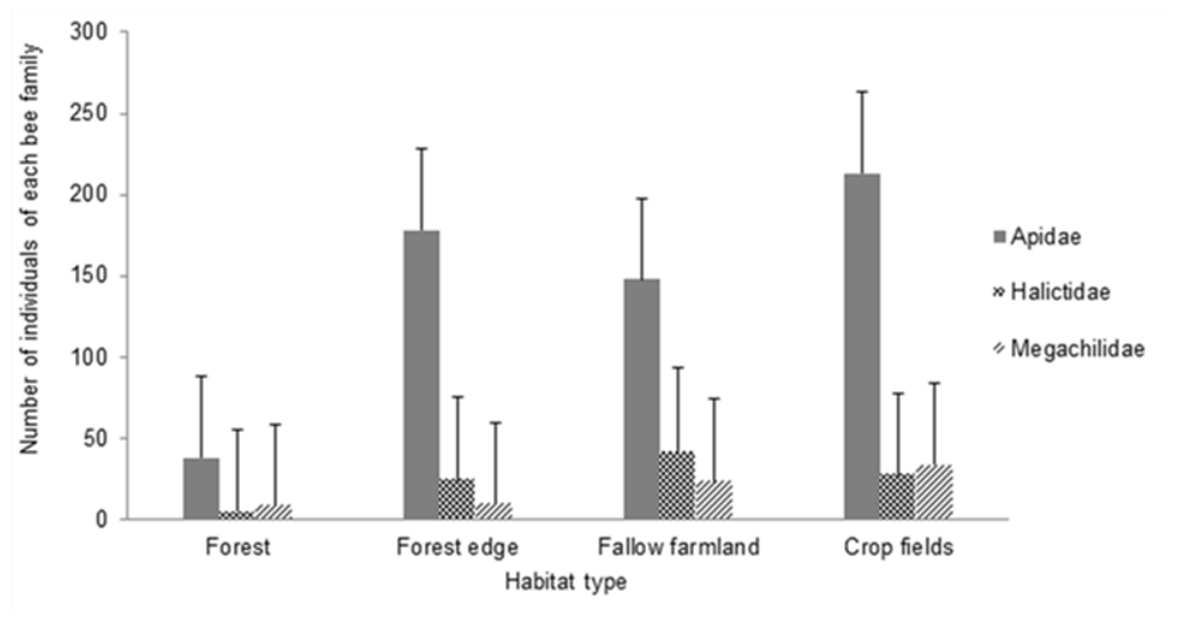
F IGURE 3: Abundance of each bee family per habitat. Bars represent number of individuals with standard